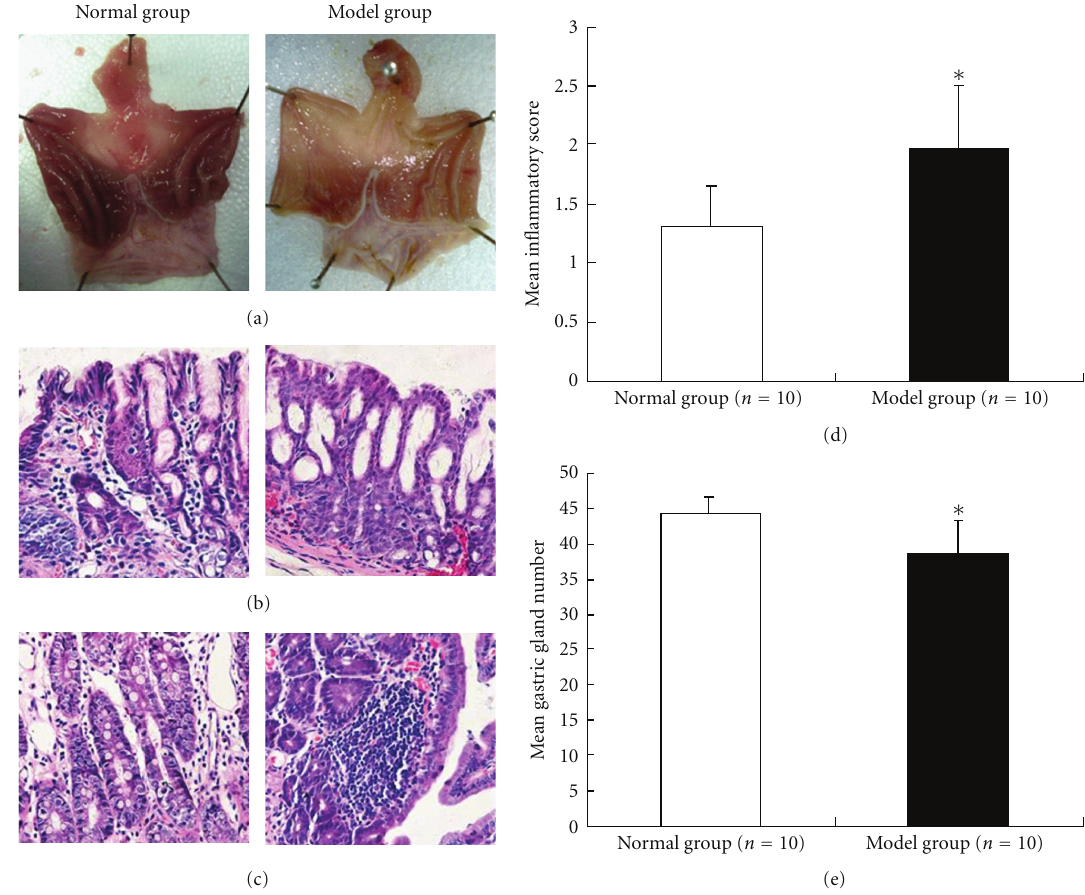
Figure 1: Pathological finding in rats with atrophic gastritis. (a) Gloss appearance of gastric mucosa. Flat with pale appearance and thin mucin on the gastric mucosa in atrophic gastritis group rats (right diagram) when compared with normal rats (left diagram). (b) H&E ( × 100) staining of gastric gland. Irregular arrangement and cystic dilation of gastric glands in atrophic gastritis (right diagram). (c) H&E ( × 200) staining showed that neutrophils and lymphocytes infiltrated into the gastric glands in rats with atrophic gastritis (right diagram). (d) The mean number of infiltrated inflammatory cells was calculated in each of 10 microscopic fields of gastric antrum glands. The mean inflammation score (mean ± s.d) was 1.95 ± 0.55 and 1.3 ± 0.34, respectively, in atrophic gastritis and normal rats. (e) The number of gastric glands in each of 1 mm area (mean ± SD) was randomly analyzed in 5 microscopic fields, which was 39.8 ± 4.59 and 44.2 ± 2.57, respectively, in atrophic gastritis and normal rats. Normal group: normal rats; Model group: atrophic gastritis rats. ∗ P < 0 . 05.